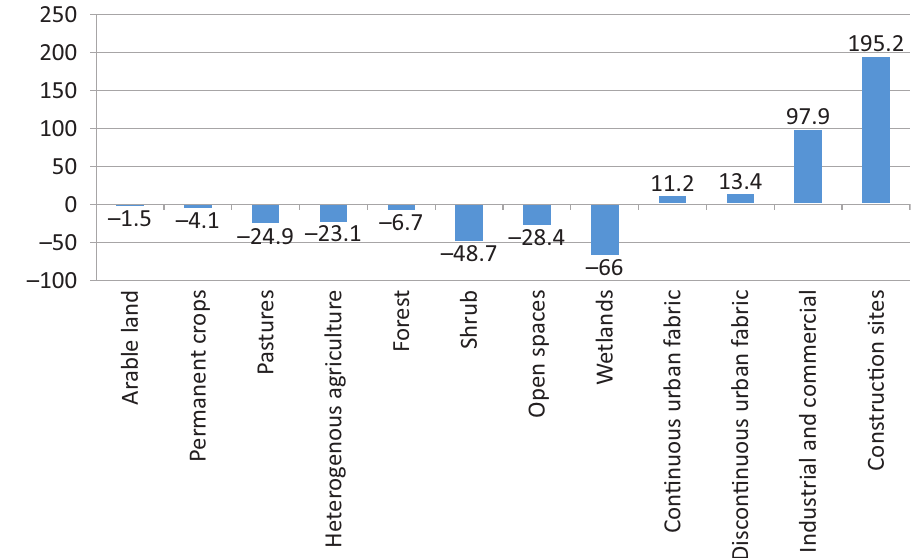
Figure 5. Percentage change of land-use classes in Hyper-Tech Scenario (2000–2025).